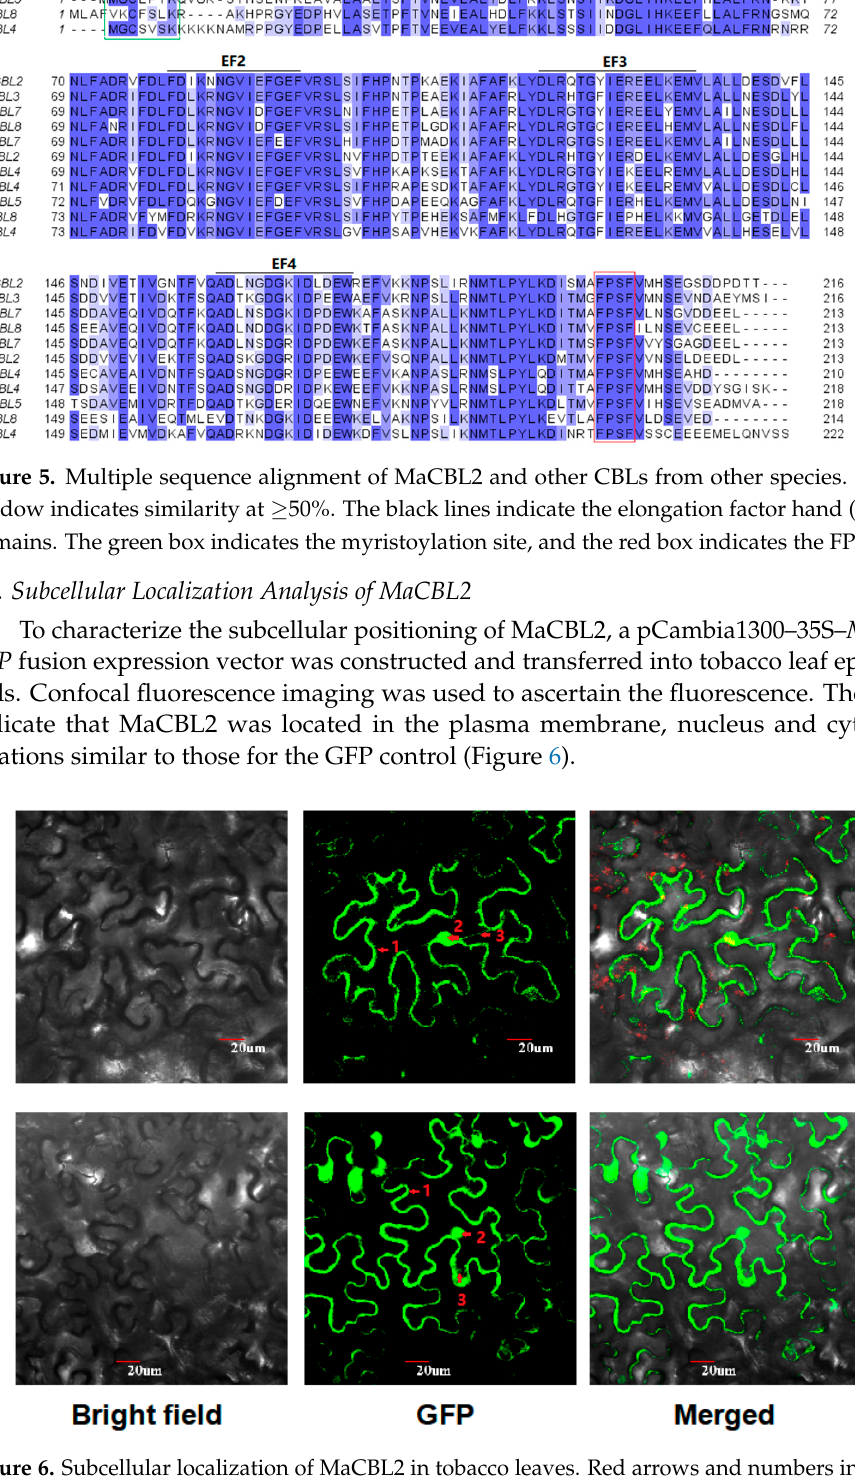
Figure 6. Subcellular localization of MaCBL2 in tobacco leaves. Red arrows and numbers indicate (1) plasma membrane, (2) nucleus, and (3)